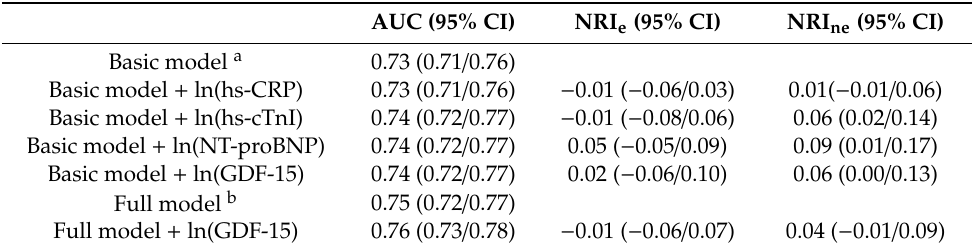
Table 4. Measures of model discrimination and reclassification for all-cause mortality in subjects with